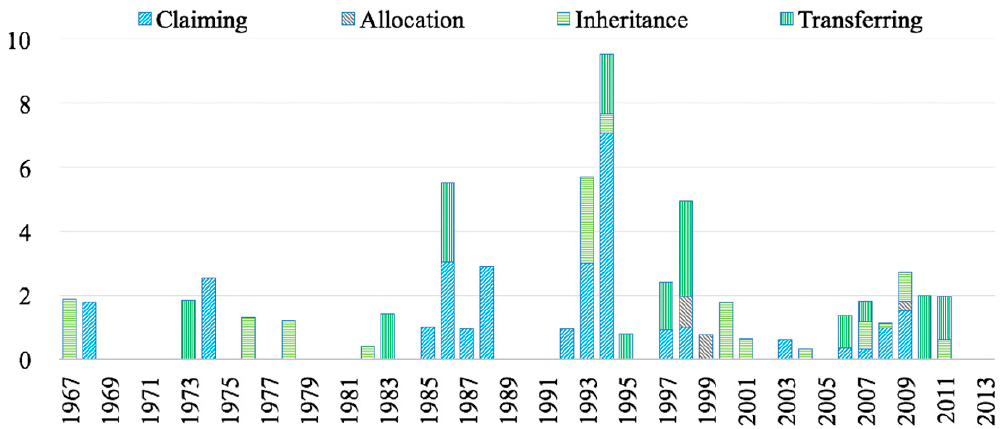
Figure 6. Sample households that obtained paddy fields. Source : Household survey.